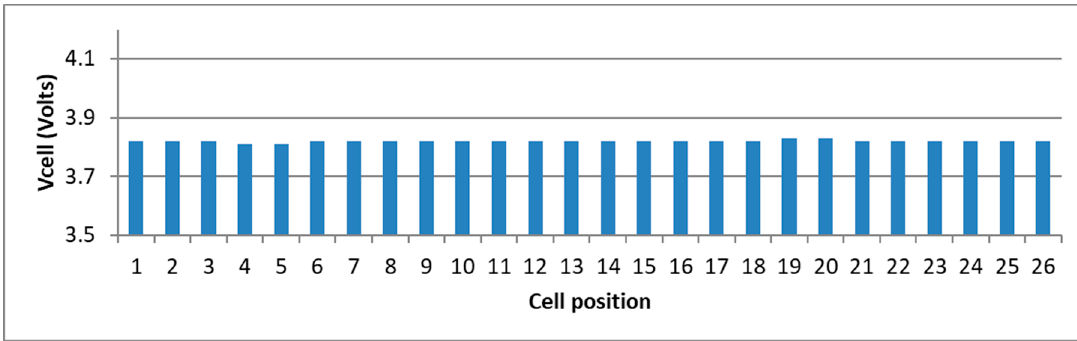
Figure 14. Battery-pack voltage measurements.